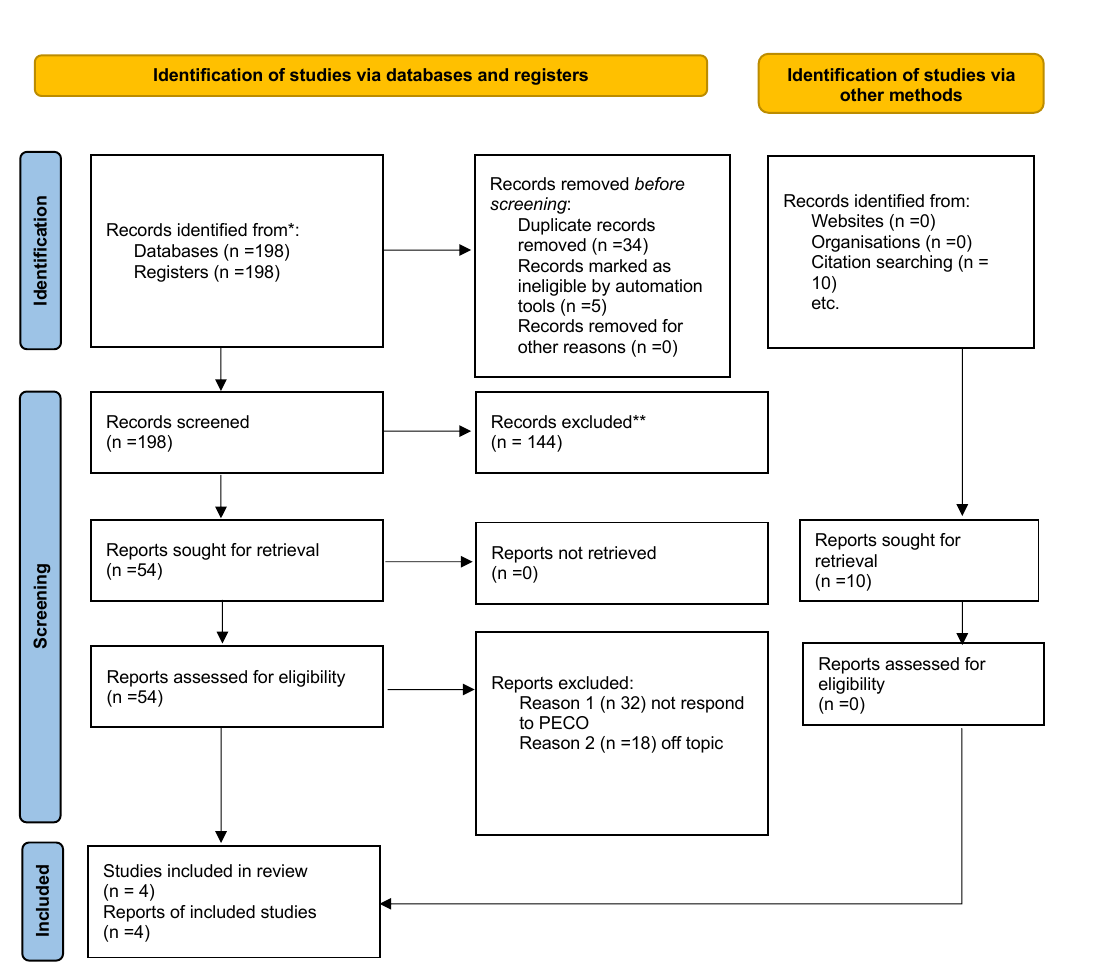
Table 1. Search strategy. PubMed Search: (temporomandibular disorder) AND (COVID) (“temporomandibular joint disorders” [MeSH Terms] OR (“temporomandibular” [All Fields] AND “joint” [All Fields] AND “disorders” [All Fields]) OR “temporomandibular joint disorders” [All Fields] OR (“temporomandibular” [All Fields] AND “disorder” [All Fields]) OR “temporomandibular disorder” [All Fields]) AND (“SARS-CoV-2” [MeSH Terms] OR “SARS-CoV-2” [All Fields] OR “COVID” [All Fields] OR “covid 19” [MeSH Terms] OR “COVID 19” [All Fields]) Web of Science (ALL = (temporomandibular disorders)) AND ALL = (COVID) Lilacs temporomandibular disorders [Palavras] and COVID [Palavras] Scopus TITLE-ABS-KEY (temporomandibular AND disorders AND COVID)